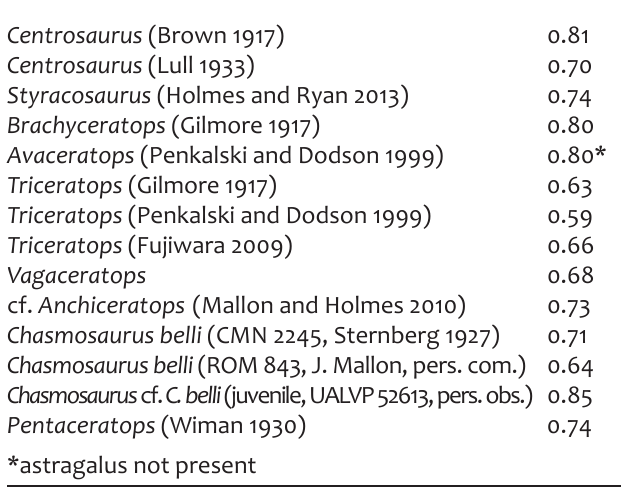
TABLE 1. Ratios of tibia/femur length in ceratopsids based on maximum femur length measured from greater tro- chanter to lateral condyle; maximum tibia length including astragalus unless otherwise indicated. References cited indicate source of measurements upon which ratios were